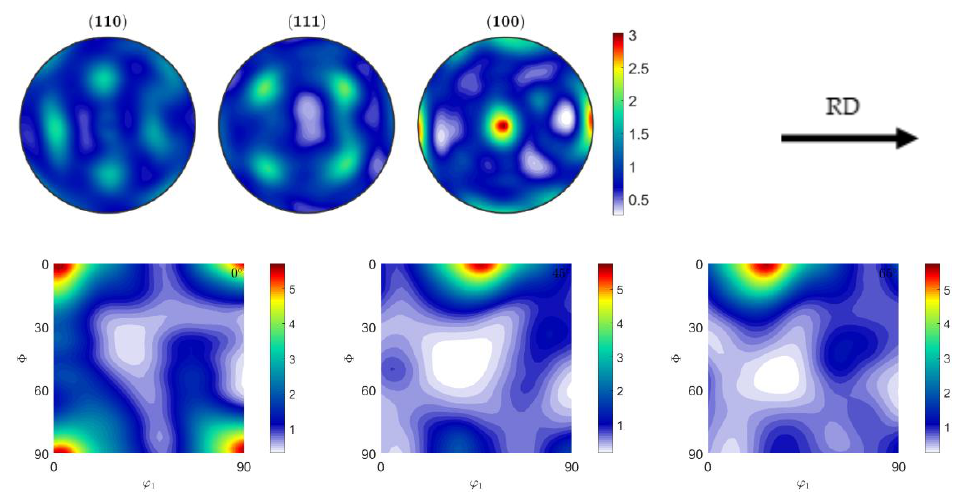
Figure 2. Pole figures {110}, {111}, and {100}, and ODF sections for φ 2 = 0° ( left ), φ 2 = 45° ( middle ), and φ 2 = 65° ( right ) of the initial material. Table 1. Chemical composition of the material as-received wt.%.